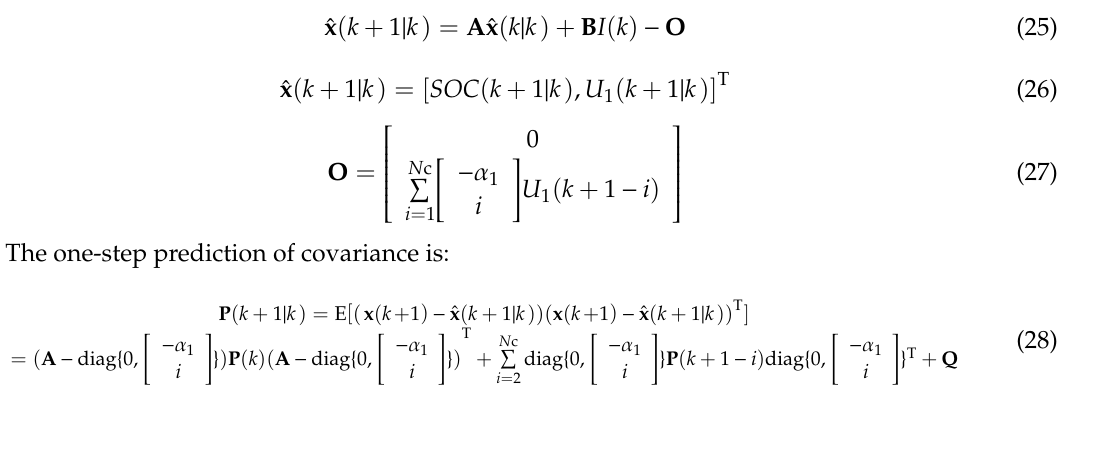
Figure 16. Comparison of terminal voltage errors between fractional model and integral model under 26 continuous DST conditions at 28 °C.